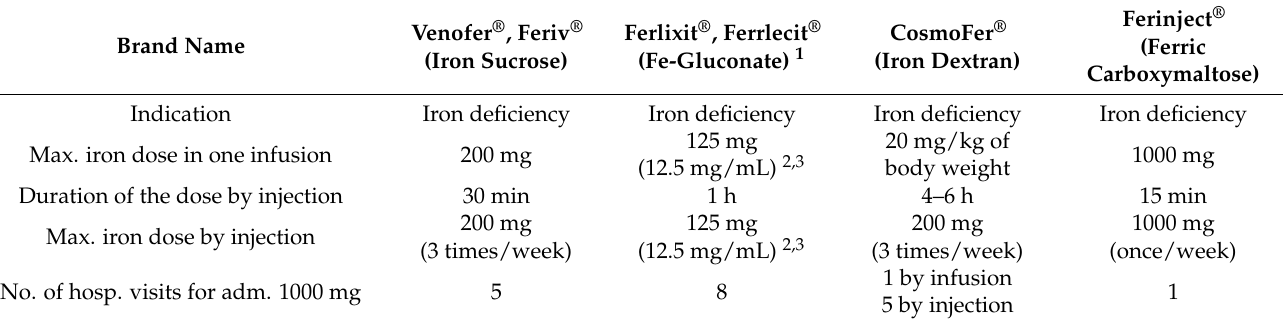
Table 4. Characteristics of the different iron formulations available 1 .